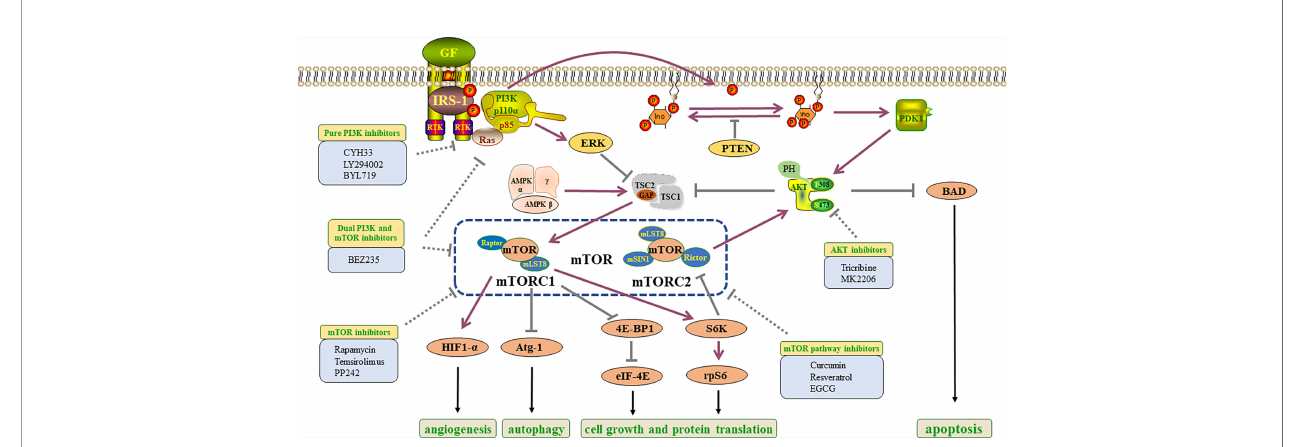
FIGURE 3 | Constituent elements and inhibitors of PI3K/AKT/mTOR pathway in ESCC. Growth factors bind to RTKs to activate the PI3K/AKT/mTOR pathway, which directly and indirectly results in tumorigenesis, the activation of protein translation and angiogenesis, the inhibition of apoptosis and autophagy. GF, growth factors; PI3K, phosphatidylinositol 3-kinase; IRS1, insulin receptor substrate 1; RTK, receptor tyrosine kinase; PIP2, phosphatidylinositol 4,5- bisphosphate; ERK, extracellular signal-related kinase; PIP3, phosphatidylinositol 3,4,5-trisphosphate; TSC, tuberous sclerosis protein; PTEN, phosphatase and tensin homolog; PDK1, pyruvate dehydrogenase lipoamide kinase isozyme 1; AMP,: AMP-activated protein kinase; AKT, protein kinase B; mTORC, mammalian target of rapamycin complex; BAD, Bcl2-related death protein; Raptor, regulatory associated protein of mTOR; HIF1- a , Hypoxia-inducible factor 1- a ; mLST8, mammalian lethal with sec-13 protein 8; eIF4E, eukaryotic translation initiation factor 4E; mSIN1, mammalian stress-activated MAPK- interacting protein 1; Rictor, rapamycin insensitive companion of mTOR; Atg-1, autophagy-related protein 1; 4E-BP1, 4E-binding protein 1; S6K, ribosomal S6 kinase; rpS6, ribosomal protein